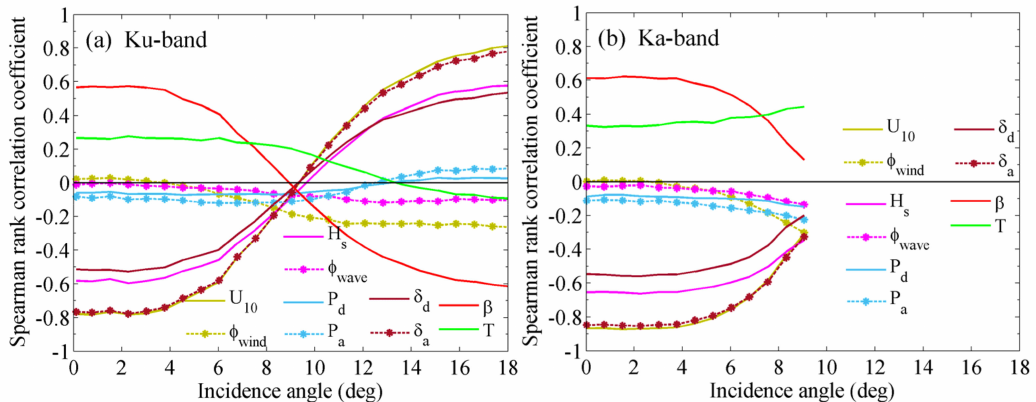
Figure 3. Spearman rank correlation coefficients between ( a ) KuPR σ 0 , ( b ) Ka-band precipitation radar (KaPR) σ 0 and surface wind, wave and temperature parameters as functions of radar incidence